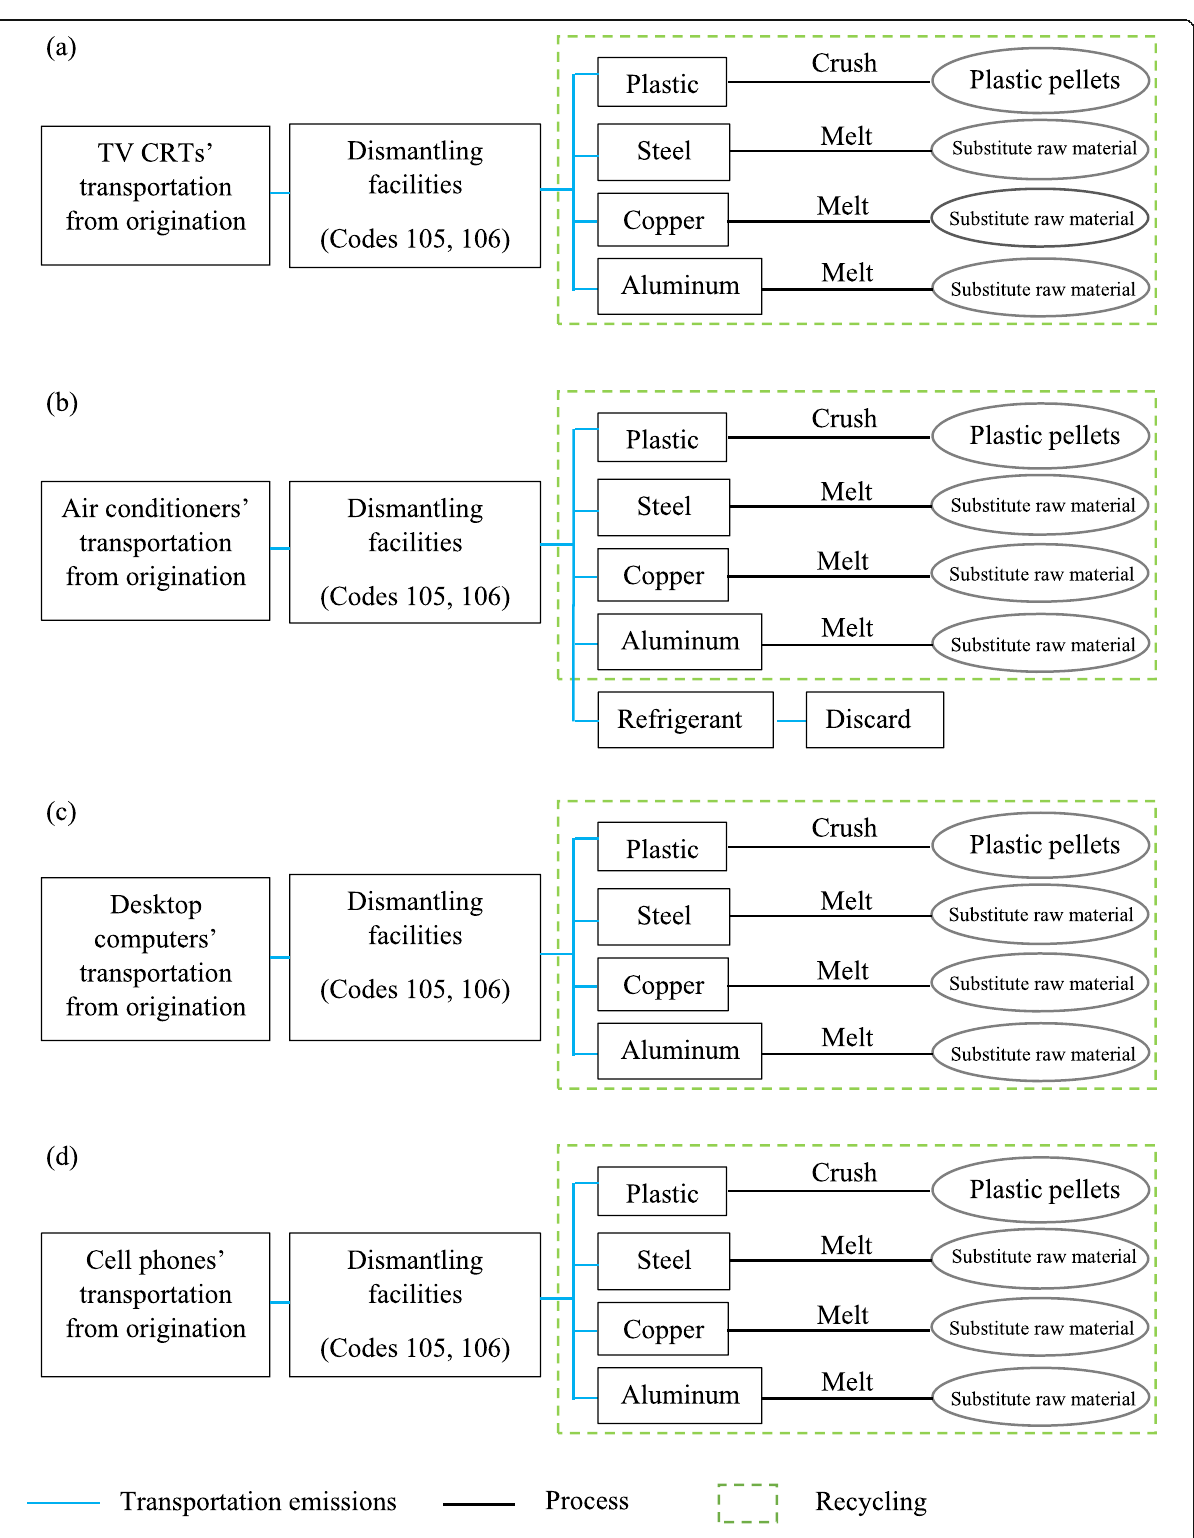
Fig. 2 Life cycle GHG of all four types of e-waste of ( a ) television CRT screens, ( b ) air conditioners, ( c ) desktop computers, and ( d )